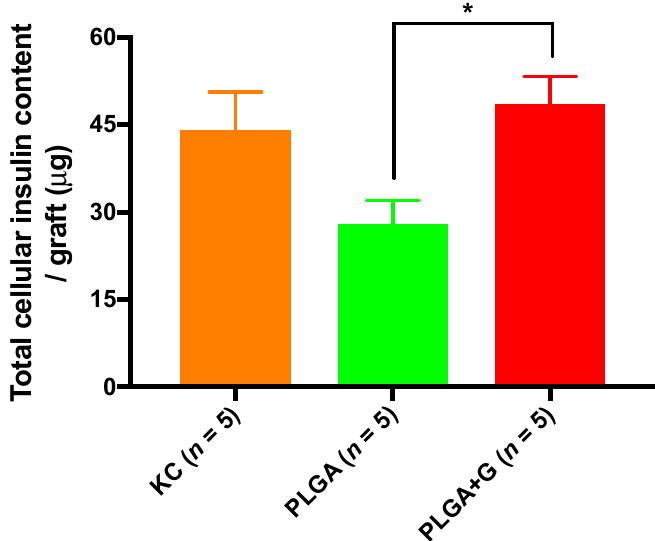
Figure 6. Total cellular insulin contents of the grafts at 27 weeks post-transplant. There were comparable insulin contents between the KC and PLGA + G scaffold ( p > 0.05, one-way ANOVA). Of note, grafts from PLGA + G had higher total cellular insulin contents compared to the PLGA scaffold (* p < 0.05, one-way ANOVA).